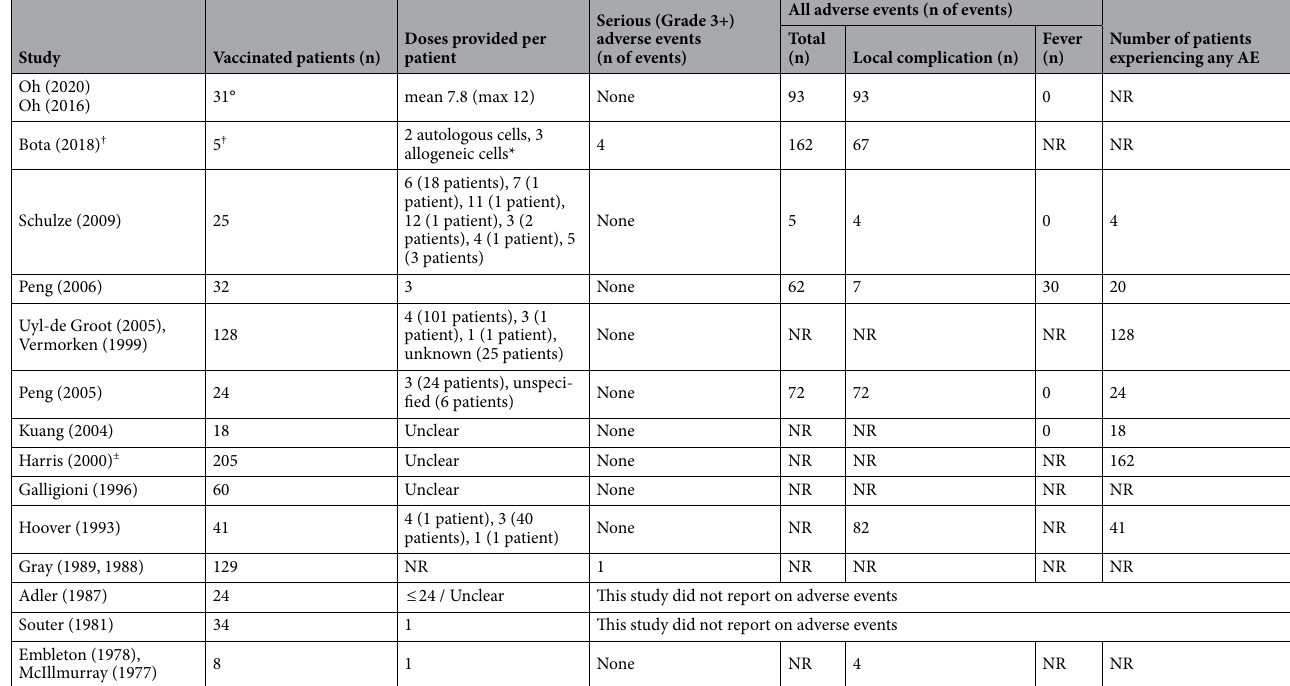
Table 3. Adverse events. NR not reported. °31 patients received vaccination; 20 of these patients were randomized to the vaccine group and 11 additional patients were placed in the vaccine group in a de-randomized fashion. † Bota (2018) was the only study to provide information on AEs for control; 8 serious AEs, 58 total AEs in control group. *in the study by Bota et al. (2018) it was unclear how many cycles of the 2 autologous cell and 3 allogeneic cell vaccines were provided. ± although only 150 patients were considered “analyzable” in the study by Harris (2000), 205 were vaccinated.